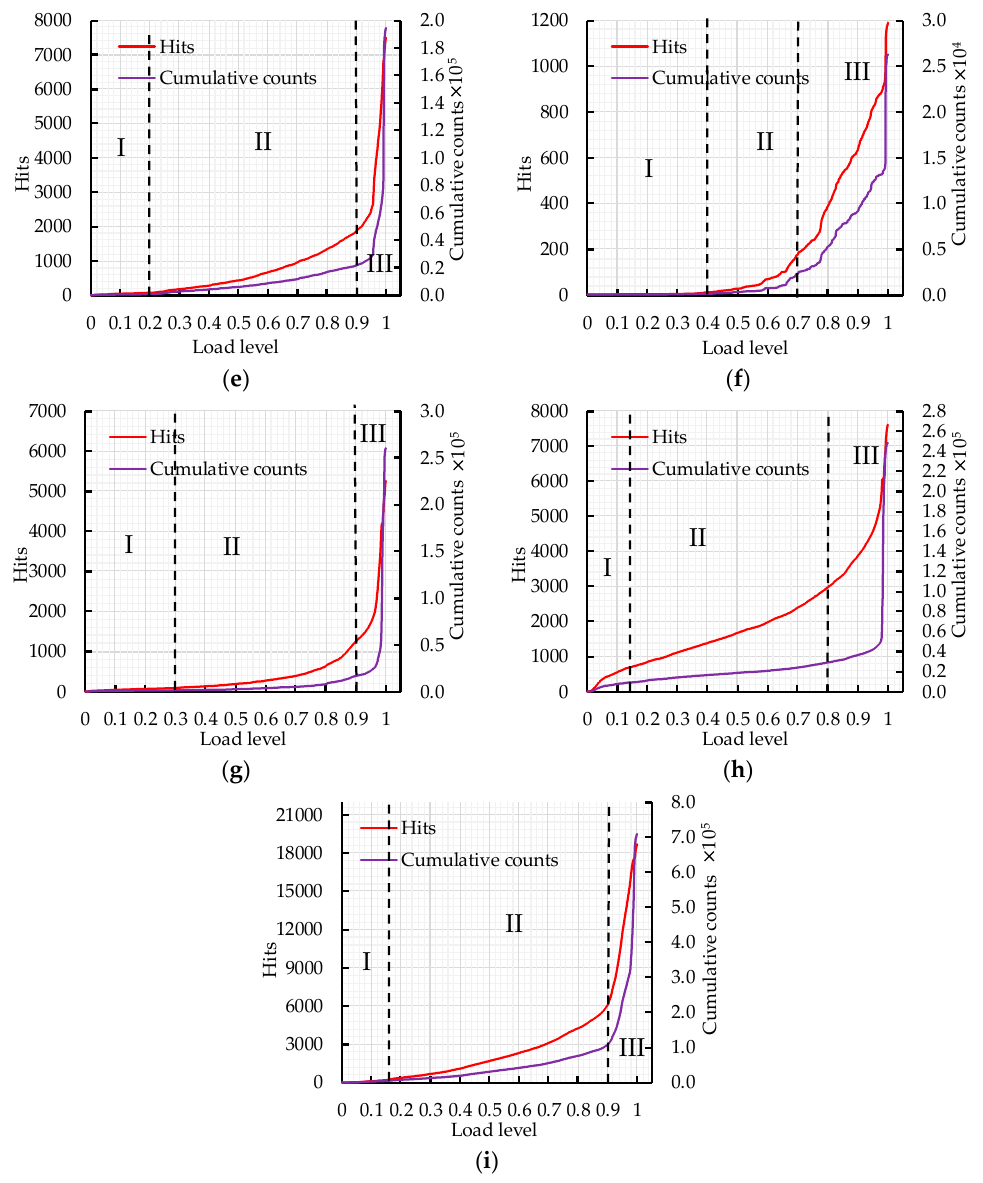
Figure 7. The curve of cumulative AE hits and counts versus load level: ( a ) A1; ( b ) A2; ( c ) A3; ( d ) A4; ( e ) A5; ( f ) A6; ( g ) A7; ( h ) A8; ( i ) A9.